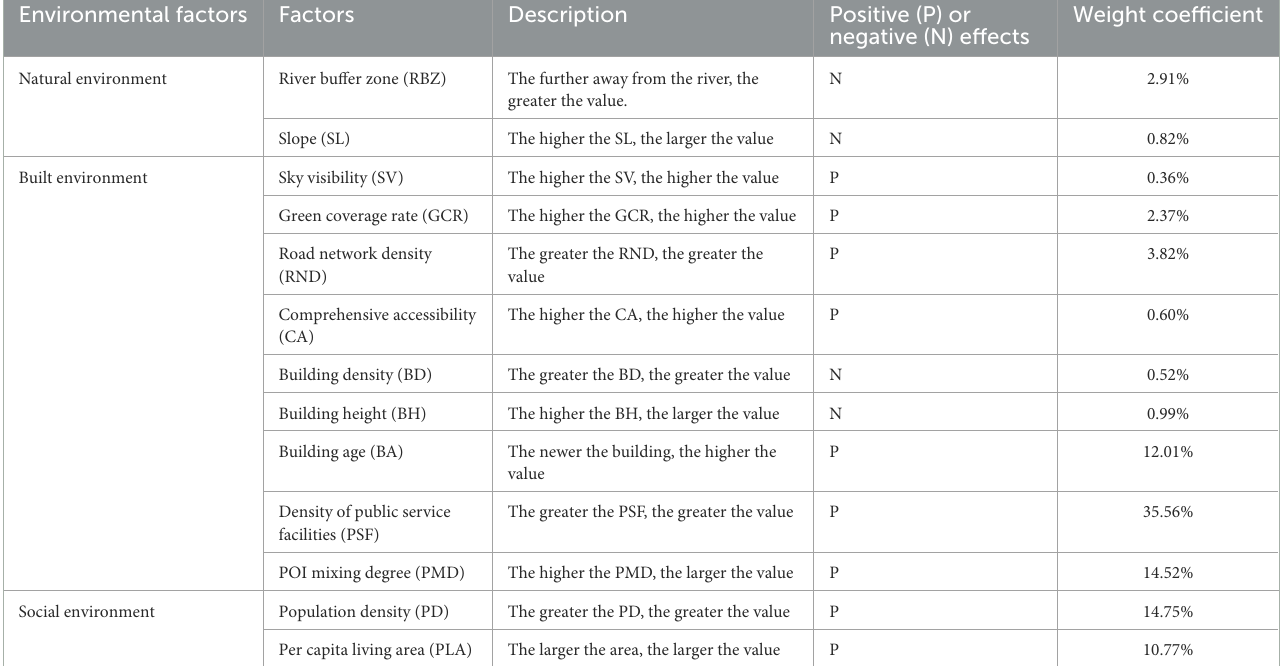
TABLE 2 Objective environmental comfort